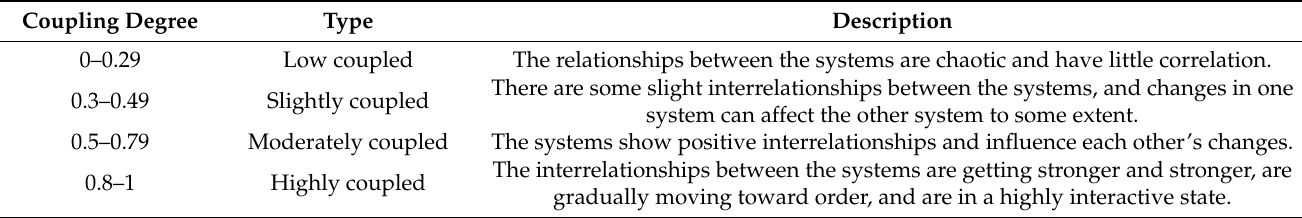
Table 2. Classification of the coupling degree.